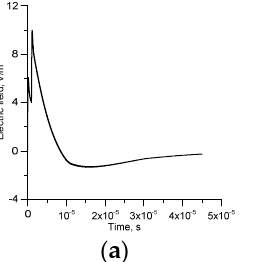
Figure 12. The e ff ect of increasing the duration of the backward moving electron current. ( a ) τ n = 1 µ s; Figure 12 . The effect of increasing the duration of the backward moving electron current. ( a ) ( b ) τ n = 3 µ s; ( c ) τ n = 7.5 µ s. The rest of the parameters are identical to those of Figure 8b. τ τ = 3 μ s; ( c ) = 7.5 μ s. The rest of the parameters are identical to those of Figure 8b. n n